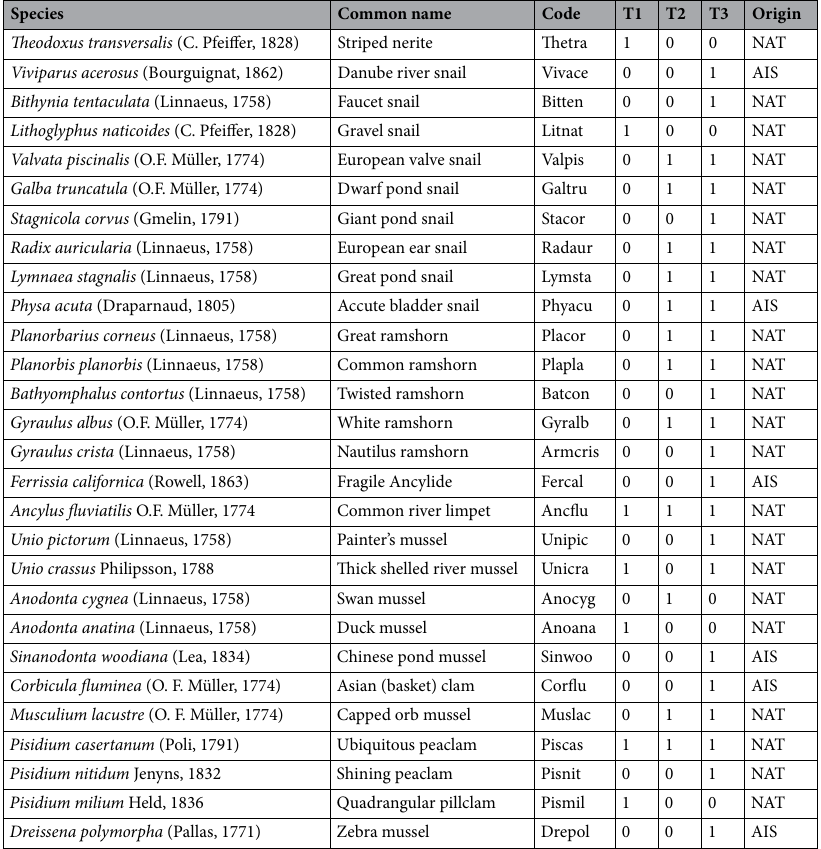
(native and AIS) —FD(Rao). Because the functional traits are a mixture of factorial and quantitative variables, we performed principal coordinates analysis (PCoA) on all traits using the Gower distance, saved the axes scores on all axes with non-zero eigenvalues, and calculated the FD on these scores and the corresponding community (sites-by-species) data tables. The predictors used for T1–T3 binary data were: Period (time), Hab (habitat category) with levels (R) river, (L) lakes (i.e., reservoirs) and (C) canals, and Impact (human pressure), an ordinal variable ranging from 0 (natural conditions in the late 1800s) to 7 (most apparent impact on a river, meaning stagnant waters, places near dams, between concrete dykes). For T1, predictors were set to baseline (Hab = R and Impact = 0, meaning river close to natural status). For the T3 count data, the corresponding predictors included the formerly described ones and, in addition, the Flow, an ordinal assessment of the average flowing conditions of the waters, ranging from 1 (almost) stagnant to 5, permanent, rapid, turbulent flow, and the distance to the nearest dam downstream, Dis_dam, in m. Data analysis was performed separately on the whole community data set and on AIS in relation to the native communities. We used eleven functional traits (FT), but only some were selected during the forward selection procedures within the double-constrained ordination method and thus included in the analyses. The traits are: Taxon—facto- rial variable, with the levels (PG) prosobranch and (G) pulmonate gastropods, (U) Unionoida and (V) Veneroida bivalves; Origin—factor with levels (NAT) native and (AIS) alien invasive species; Habitat preferences—factor with (Rheo) rheophilic, (Lent) lentiphilic, (Phyt) phytophilic, (Ubi) ubiquitous; SizeM, maximal shell size—ordi- nal variable with the values: (1) < 2.5 mm, (2) 2.6–5 mm, (3) 5.1–15 mm, (4) 15.1–50 mm, (5) 50.1–100 mm, (6) > 100 mm; Sexes—factor with (S) separate sexes and (H) hermaphrodite; Ovipos, oviposition—factor with